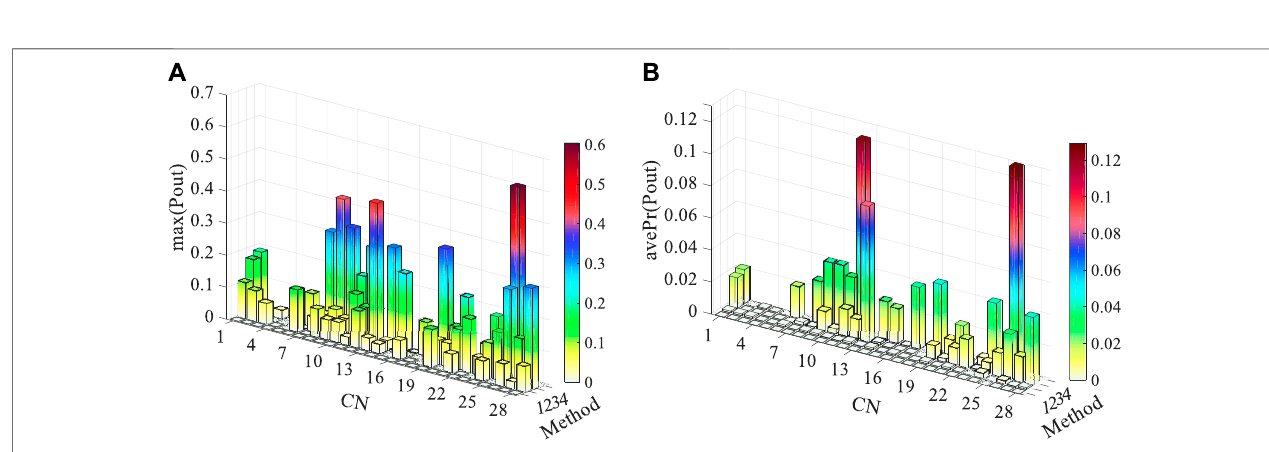
FIGURE 8 | Out-of-limit situation of branch active power. (A) Maximum out-of-limit situation of branch active power. (B) Average out-of-limit situation of branch active power.